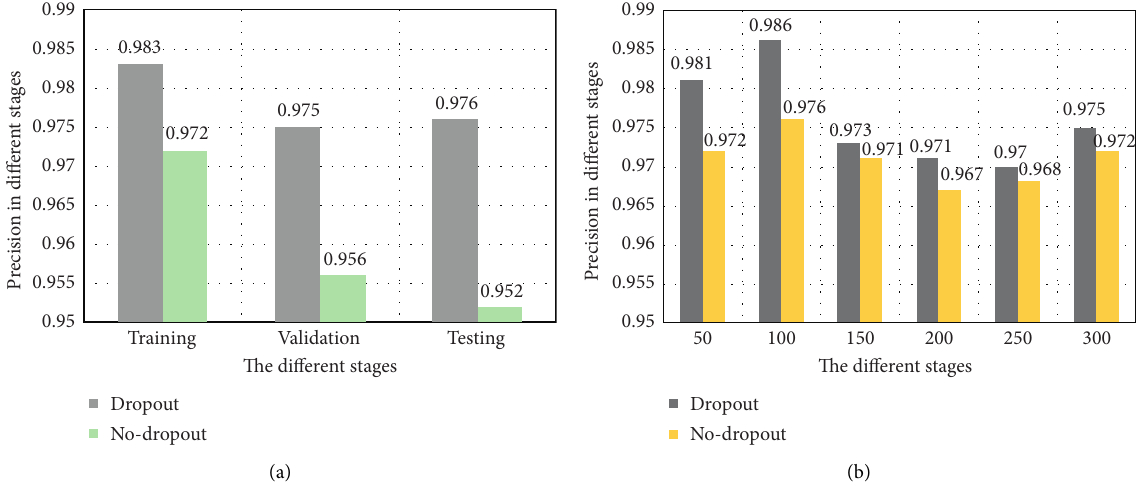
Figure 8: The influence of Dropout and dimension. (a) The role of Dropout. (b) The role of GloVe dimension.